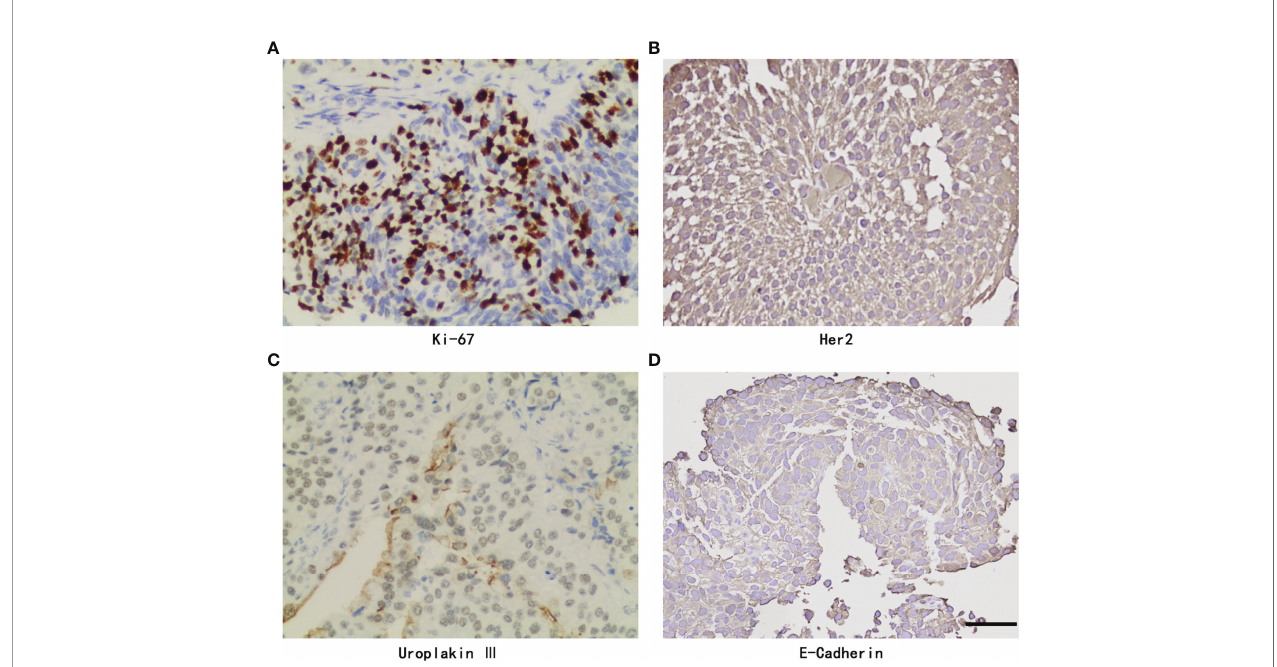
FIGURE 2 | Representative Immunohistochemistry staining of Ki-67, Her2, Uroplakin III, E-Cadherin and PD-L1 with positive expression in UTUC. (A) Ki-67 staining. (B) Her2 staining. (C) Uroplakin III staining. (D) E-Cadherin staining. original magnifcation,×400. Scale bar, 50 m